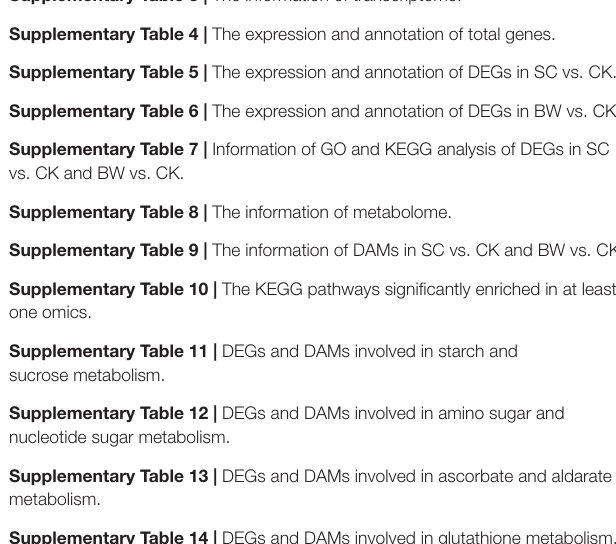
Supplementary Table 3 | The information of